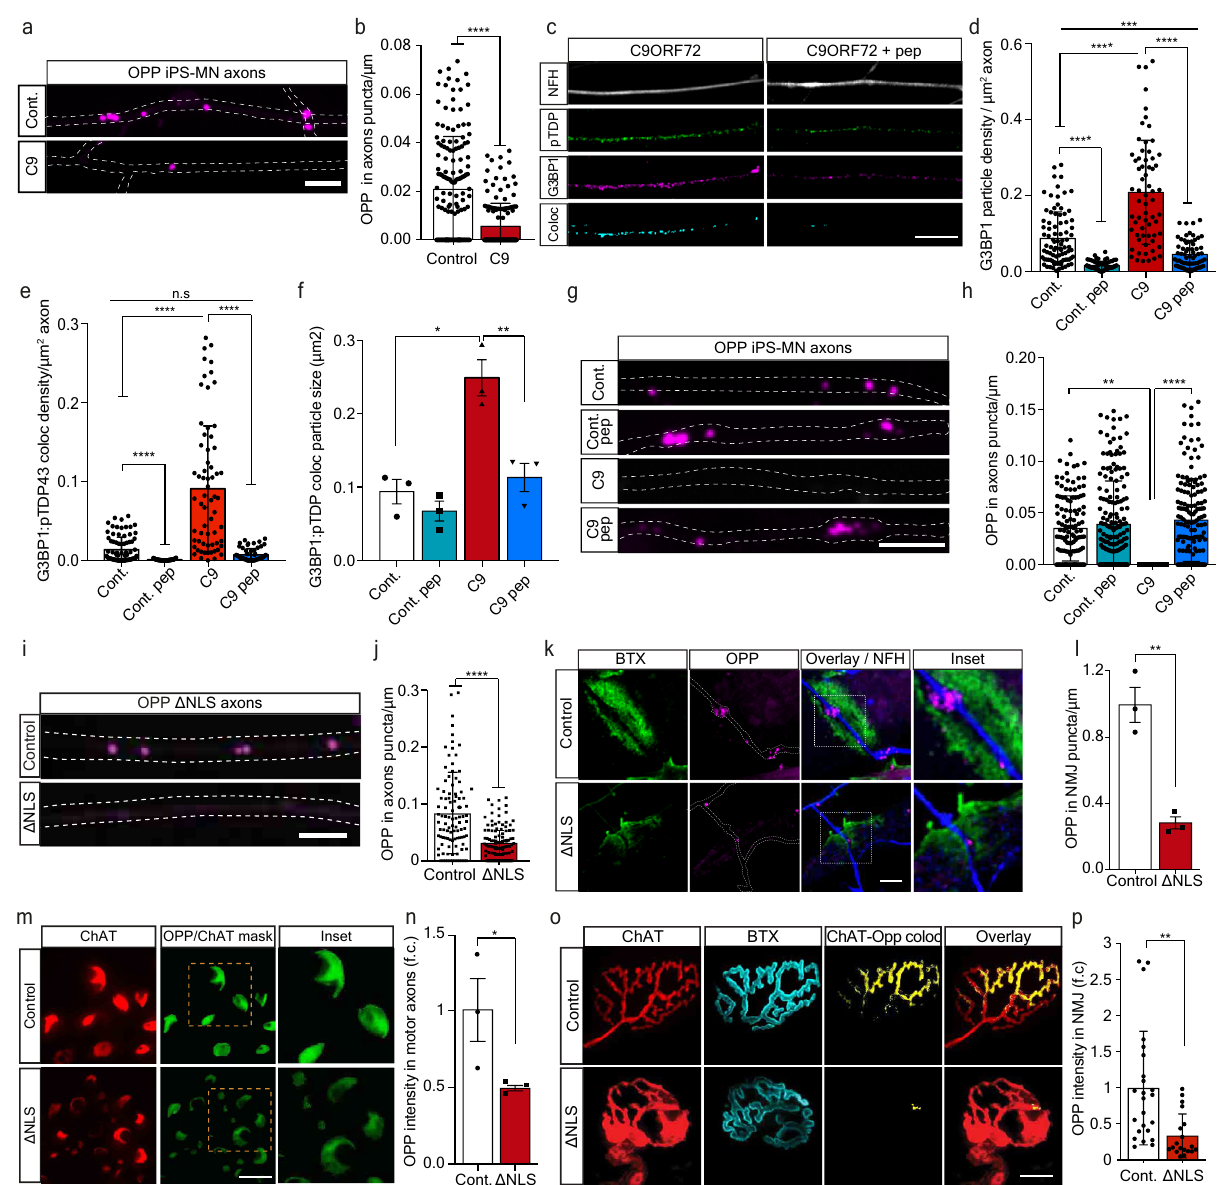
Fig. 3 TDP-43 mediated formation of axonal condensates reduces Local Synthesis in MN axons and NMJs. a Images and b quanti fi cation of OPP puncta density in C9ORF72 or control iPS-MN axons. Scale bar = 5 µ m. n = 159,144 axons. Data are presented as mean values ± SD. Unpaired- t -test, two-sided **** p < 0.0001. c Images and d – f quanti fi cation of NFH, pTDP-43 and G3BP1 and their colocalization in C9ORF72 iPS-MN axons either treated or not with G3BP1 peptide. Quanti fi cations of G3BP1 particle density ( d ), G3BP1-pTDP-43 coloc-particle density ( e ) and G3BP1-pTDP-43 coloc-particle size ( f ) from C9ORF72 and control iPS-MN axons, either treated or not with G3BP1 peptide. Scale bar = 10 µ m. n ( d and e ) = 91,71,65,68 axons, n ( f ) = 3 repeats, each over 1000 particles. Data are presented as mean values ± SD. One-way-ANOVA with Holm-Sidak correction. * P = 0.0151,** P = 0.0074, *** P = 0.0005, **** p < 0.0001. g Images and h quanti fi cation of OPP puncta density from C9ORF72 and control iPS-MN axons either treated or not with G3BP1 peptide. Scale bar = 5 µ m. n = 130,71,193,173 axons. Data are presented as mean values ± SD. One-way-ANOVA with Holm-Sidak correction. ** P = 0.094, **** p < 0.0001. i Images and j quanti fi cation of OPP puncta density in control or Δ NLS MN axons. Scale bar = 5 µ m. n = 100,112 axons. Data are presented as mean values± SD. Unpaired- t -test, two-sided. **** p < 0.0001. k Images and l quanti fi cation of OPP puncta density in in-vitro NMJs from control or Δ NLS co-cultures. BTX indicates post-synapse, NFH indicates pre-synapse. Scale bar = 5 µ m. n = 3 independent repeats. Data are presented as mean values ± SEM. Unpaired- t -test, two-sided. ** P = 0.0031. m Images and n quanti fi cation of OPP-labeled sciatic nerve sections from TDP Δ NLS ChAT::tdTomato or control ChAT::tdTomato mice. Scale bar = 10 µ m. Data are presented as mean values± SEM. n = 3,3 mice. Unpaired- t -test, one-sided. * P = 0.0364. o Images and p quanti fi cation of pre-synaptic OPP in NMJs from TDP Δ NLS ChAT::tdTomato or control ChAT::tdTomato mice. Scale bar = 10 µ m. Data are presented as mean values ± SD. n = 24,19 NMJs, from 3,3 mice. Unpaired- t -test, two-sided. ** P < 0.0044. f.c stands for Fold Change. Source data are provided as a Source Data fi